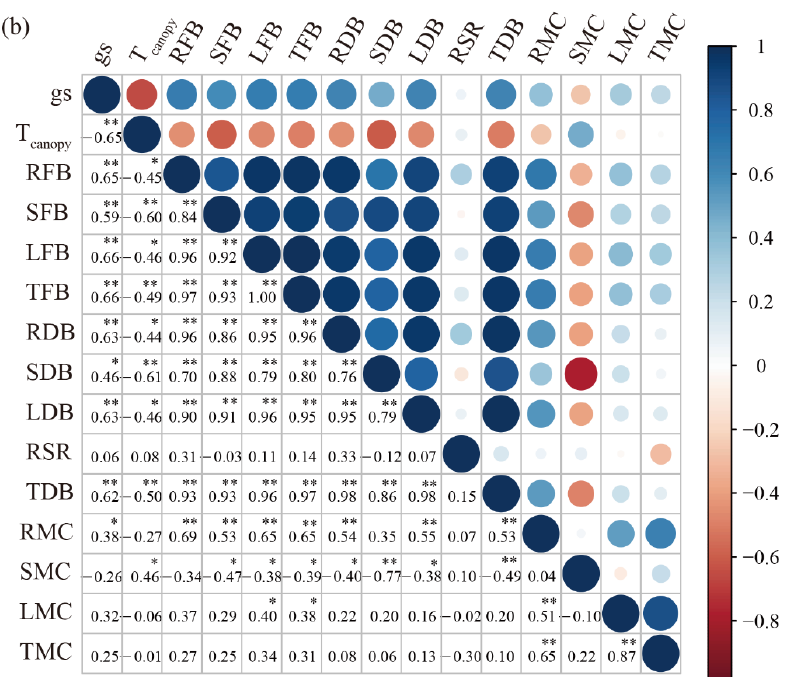
Figure 6. ( a ) Pearson correlation analysis of each factor in the control and inoculation treatments except AMF, ( b ) Pearson correlation analysis of each factor in control and inoculation treatments.